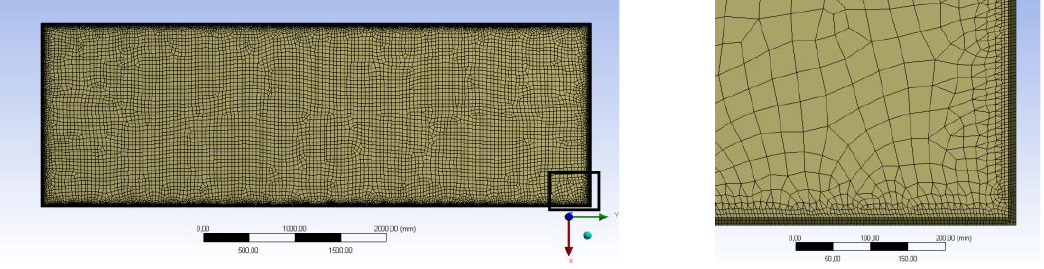
Fig. 1 Mesh of a flat rectangular panel with ANSYS Workbench 19.0.